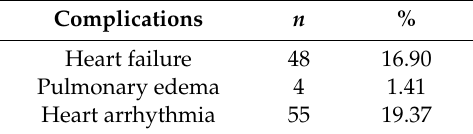
Table 4. Functional class of heart disease according to New York Heart Association (NYHA) classification ( n = 48).